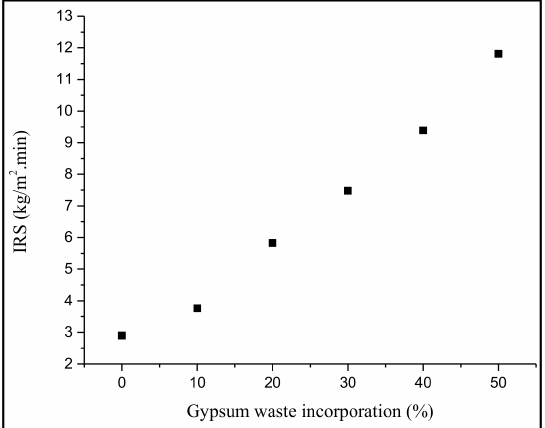
Figure 4. Effect of gypsum waste utilization on the initial rate of suction of fired clay brick.